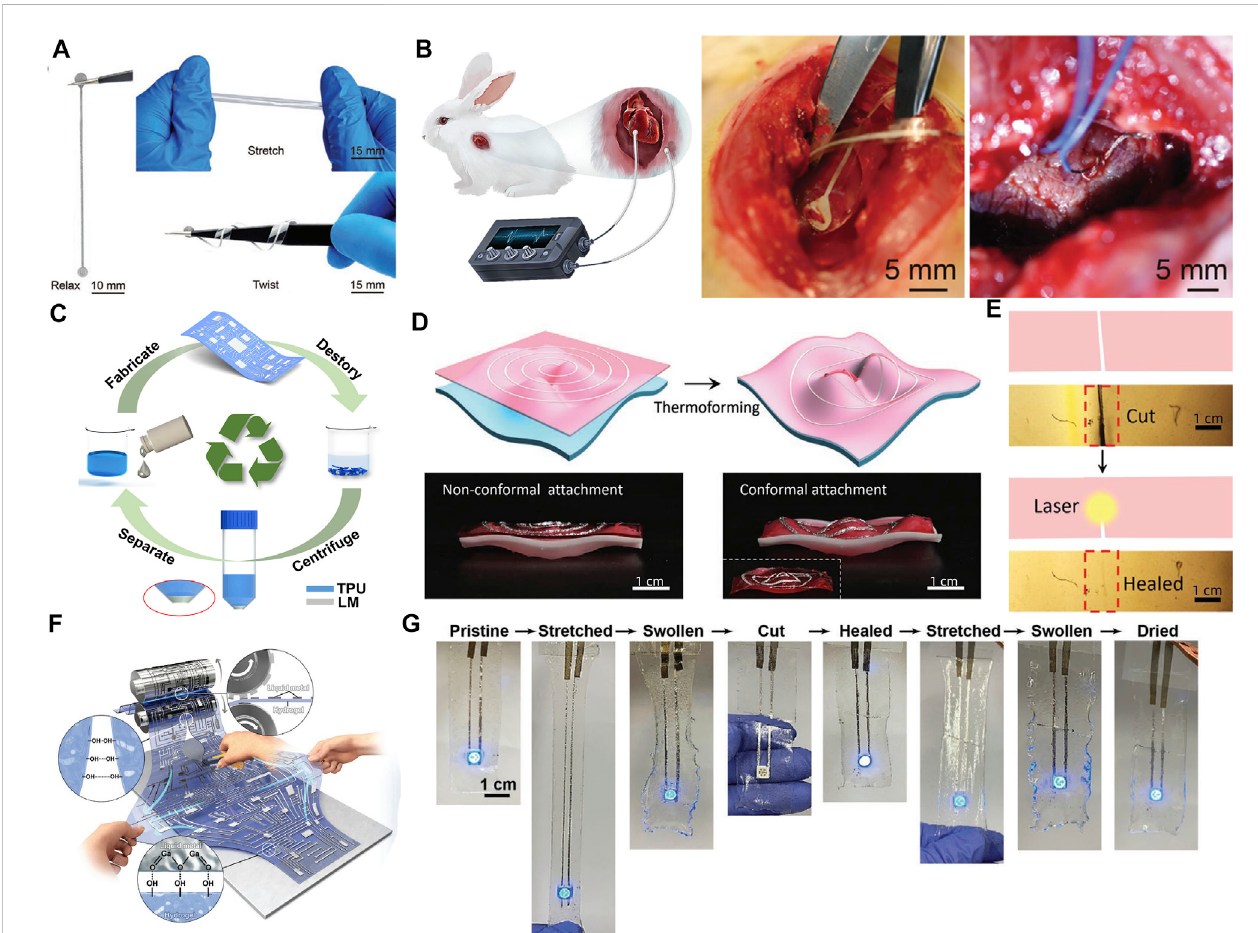
Degradable and self healing conformal electronics. (A) Snapshots of the saTPW undergoing different treatments such as relax, stretch, and twist (Hang et al., 2021). Copyright@2021, Wiley (B) Illustration of saTPW for correcting abnormal heart rates. (Hang et al., 2021). Copyright@2021, Wiley (C) Schematic of thecyclicprocessof fl exibleelectronicdevicepreparation,recycling,andrecon fi guration(Wangetal.,2021b).Copyright@2021,ACS (D) Schematicanddigital photos of thermoforming process of the hydrogel to devise conformal HSE to set on curved surface (Hao et al., 2022). Copyright@2022, Wiley (E) Schematicandphotosoflaser-inducedhealingofGA-20-1.5-32hydrogel(Haoetal.,2022).Copyright@2022,Wiley (F) Schematicillustrationofadeformable and self-healable EGaIn electrode on a hydrogel (Park et al., 2020a). Copyright@2020, Wiley (G) Photographs of an EGaIn electrode on hydrogel under consecutive mechanical conditions of stretching, swelling in water, cutting, and self-healing (Park et al., 2020a). Copyright@2020,